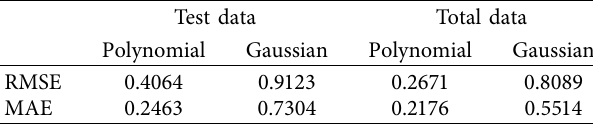
Table 9: Performance of the KSVR model for the estimation of CS.